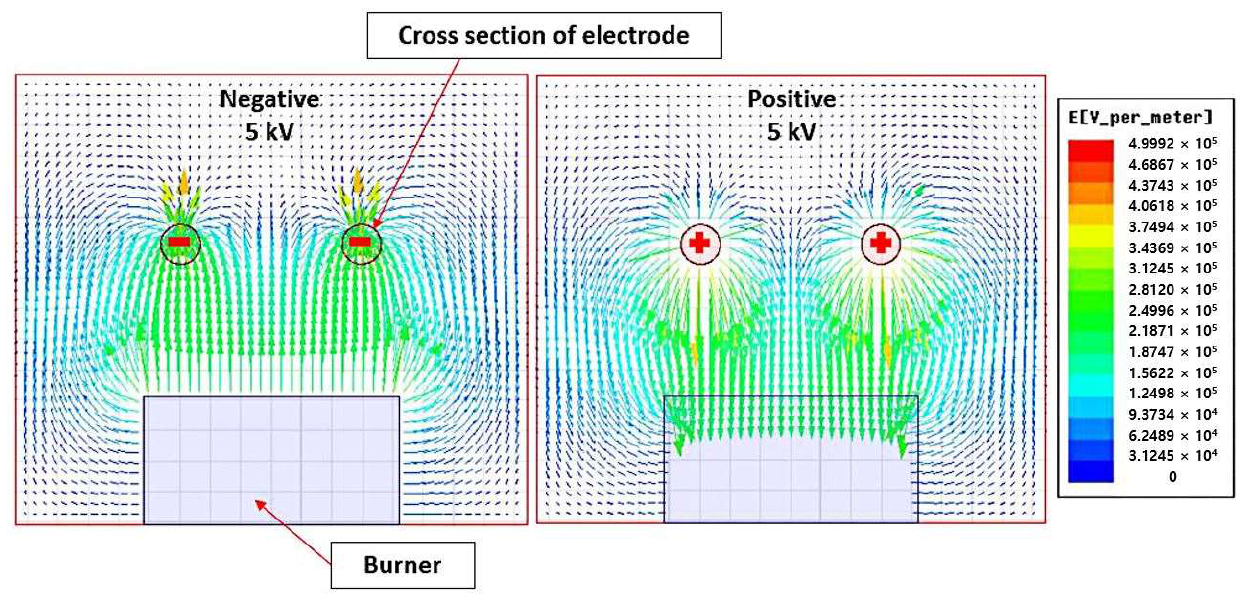
Figure 3. Demonstration of force and direction of electric field generated by radially positioned electrode.